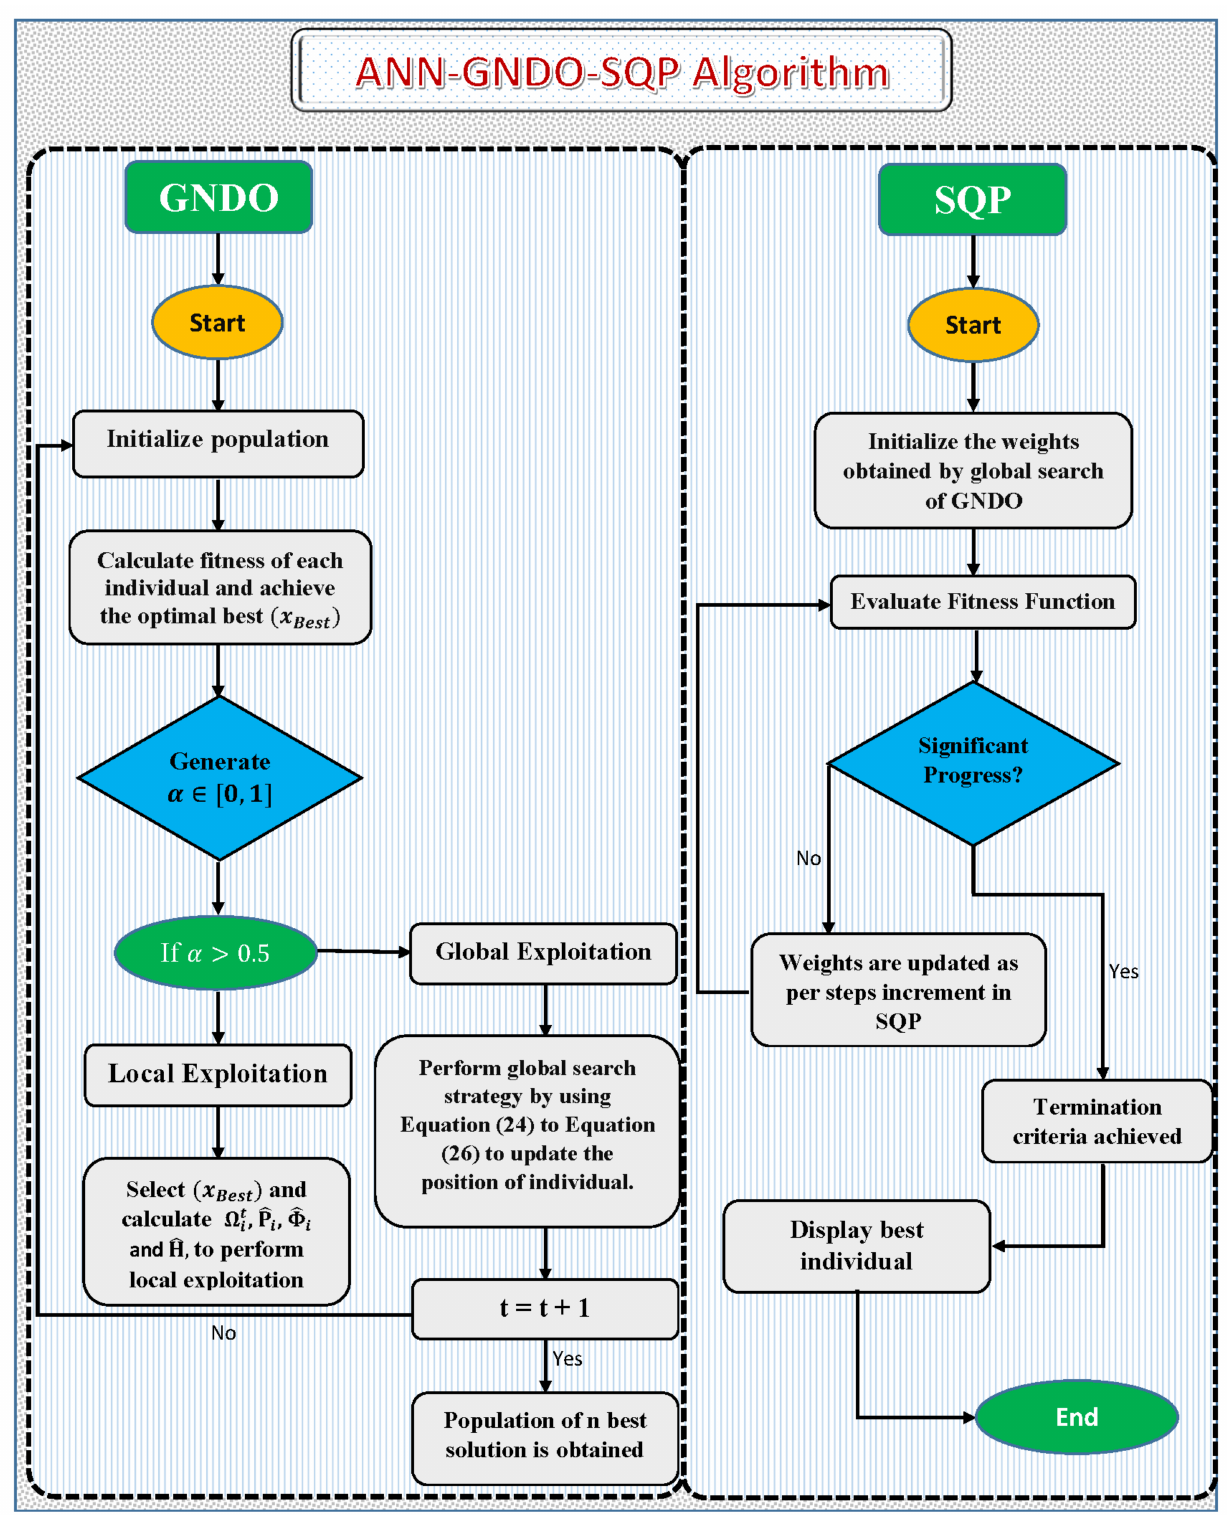
Figure 3. Workflow schematic of the proposed methodology for solving the EHD flow of